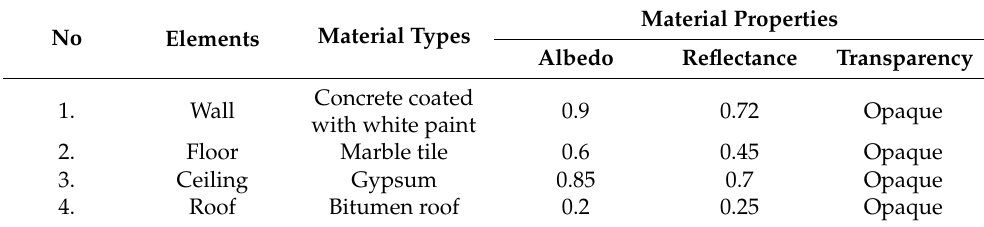
Table 3. Material specification of the heritage building. Collected from various sources